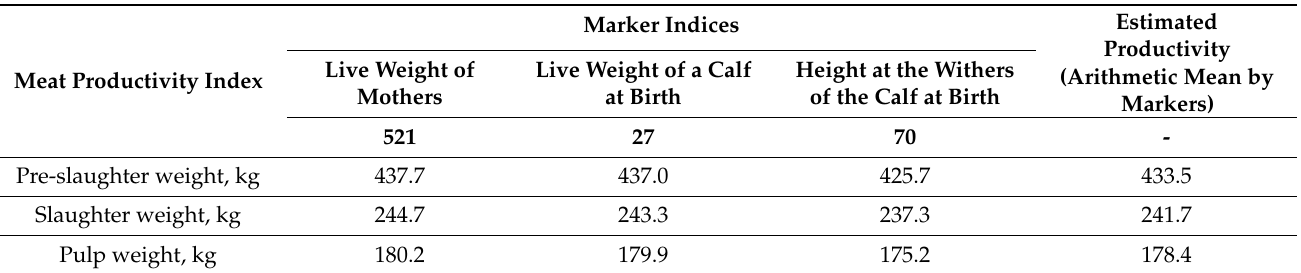
Table 6. Calculation of forecast indices for meat productivity.